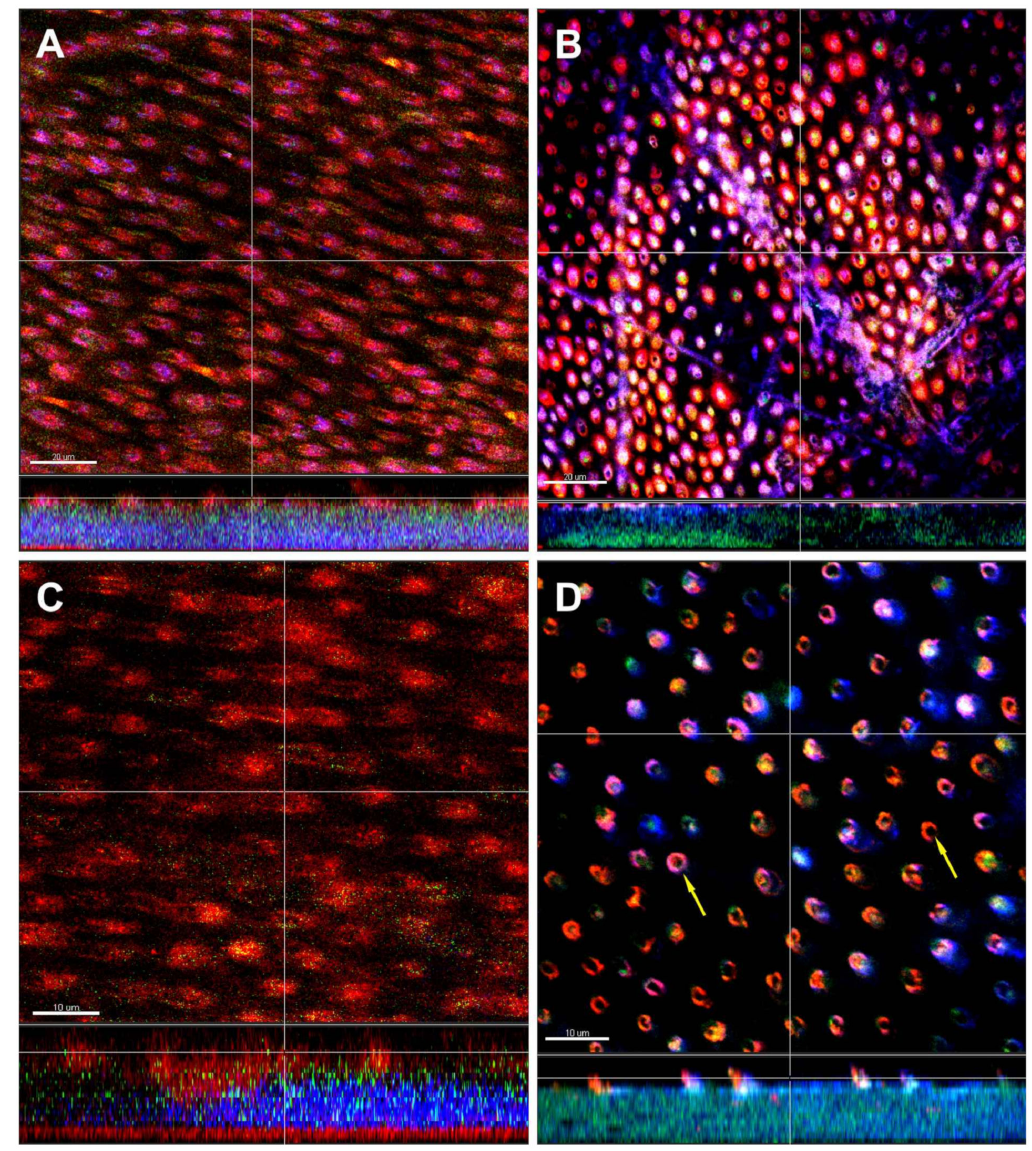
Figure 6. Confocal laser scanning microscopy (CLSM) image stacks of the basic nine species biofilm grown on dentin discs containing additionally Enterococcus faecalis ( A ), or Staphylococcus aureus ( B ), or Selenomonas sputigena ( C ), or Prevotella nigrescens ( D ). Due to FISH staining of biofilms using FITC- and Cy3-labelled probes (see Table 1), Prevotella intermedia appears green (FITC-labeled) and the newly added bacteria appear red (Cy3-labeled). Non-hybridized bacteria appear blue due to DNA staining (YoPro 59). Images were taken at the biofilm base showing dentinal tubules. The arrows indicate bacteria adhered in tubules. Scales = 20 µ m ( A , B ) and 10 µ m ( C , D